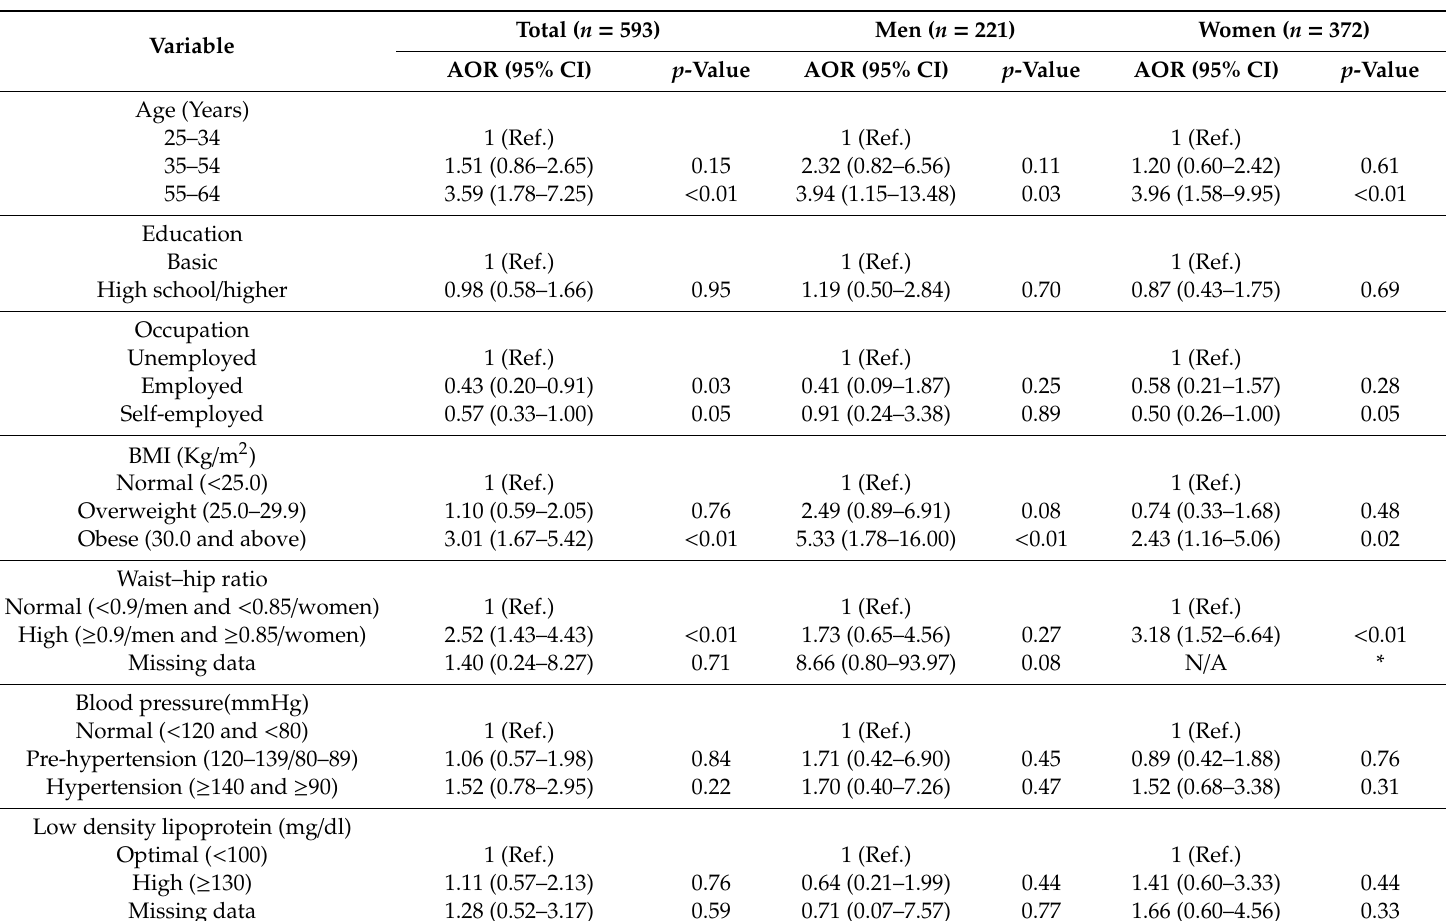
Table 5. Results of multivariate logistic regression analysis with elevated blood glucose as outcome among the residents of Kajiado County, Kenya ( n =